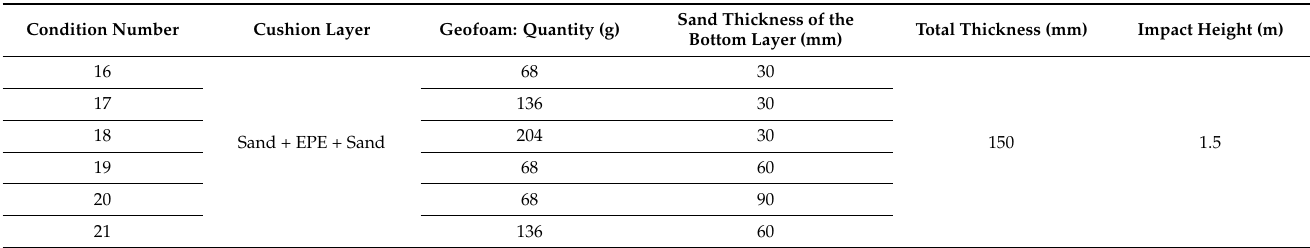
Table 2. Statistical table of multi-impact test conditions for sand–EPE